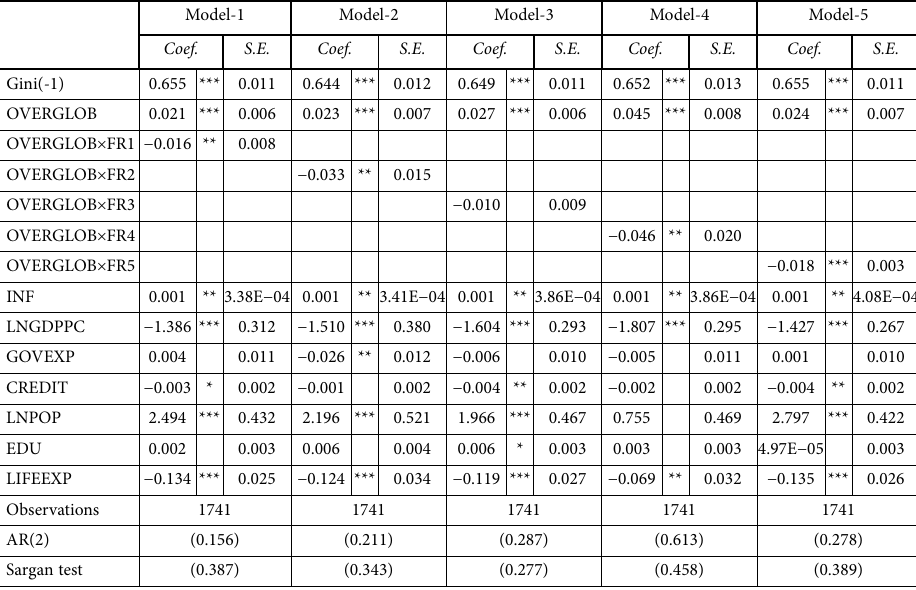
Table 7. The effects of globalization under sub-dimensions of financial risk